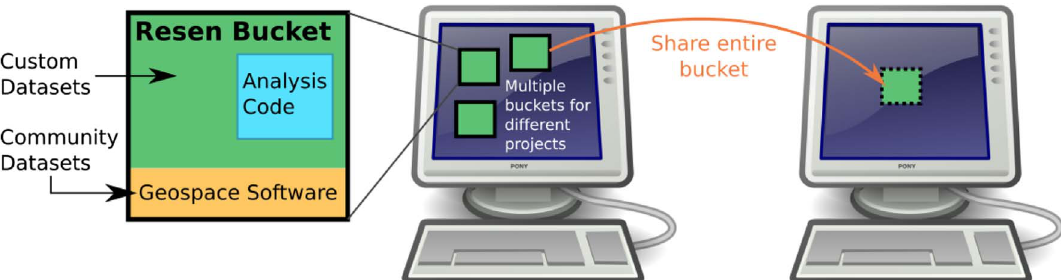
Fig. 1. Resen buckets are isolated environments where code can be developed and run on top of existing community-developed geospace software. Users can have multiple buckets at any given time, each con fi gured for and holding code needed for a particular bucket. Then, entire bucket, complete with analysis code and any custom con fi guration, can be shared with collaborators so they can quickly and easily reproduce the entire analysis.